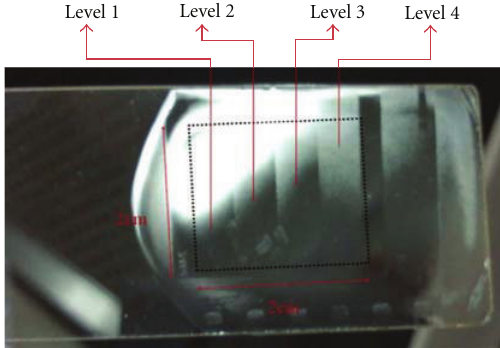
Figure 12: Gray scale microlens mold after development.